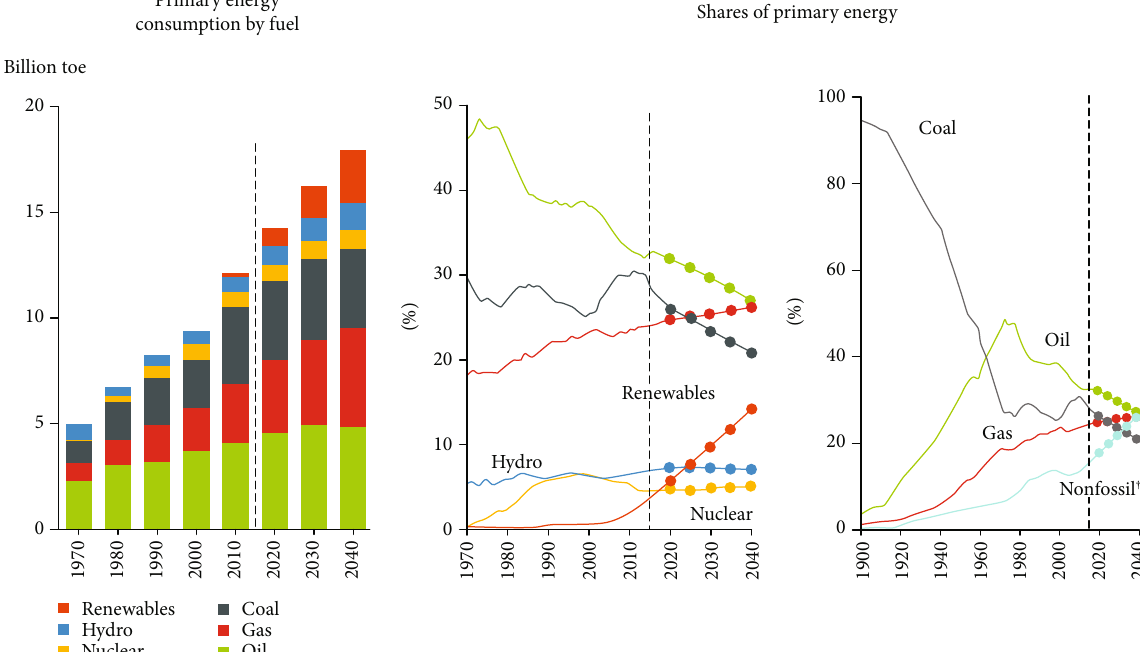
Figure 1: World energy consumption for 1970-2040